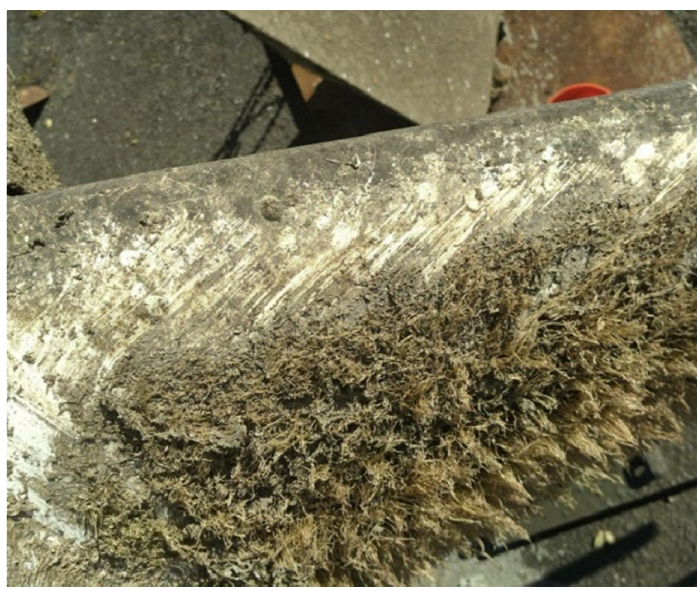
Figure 12. Marine growth on